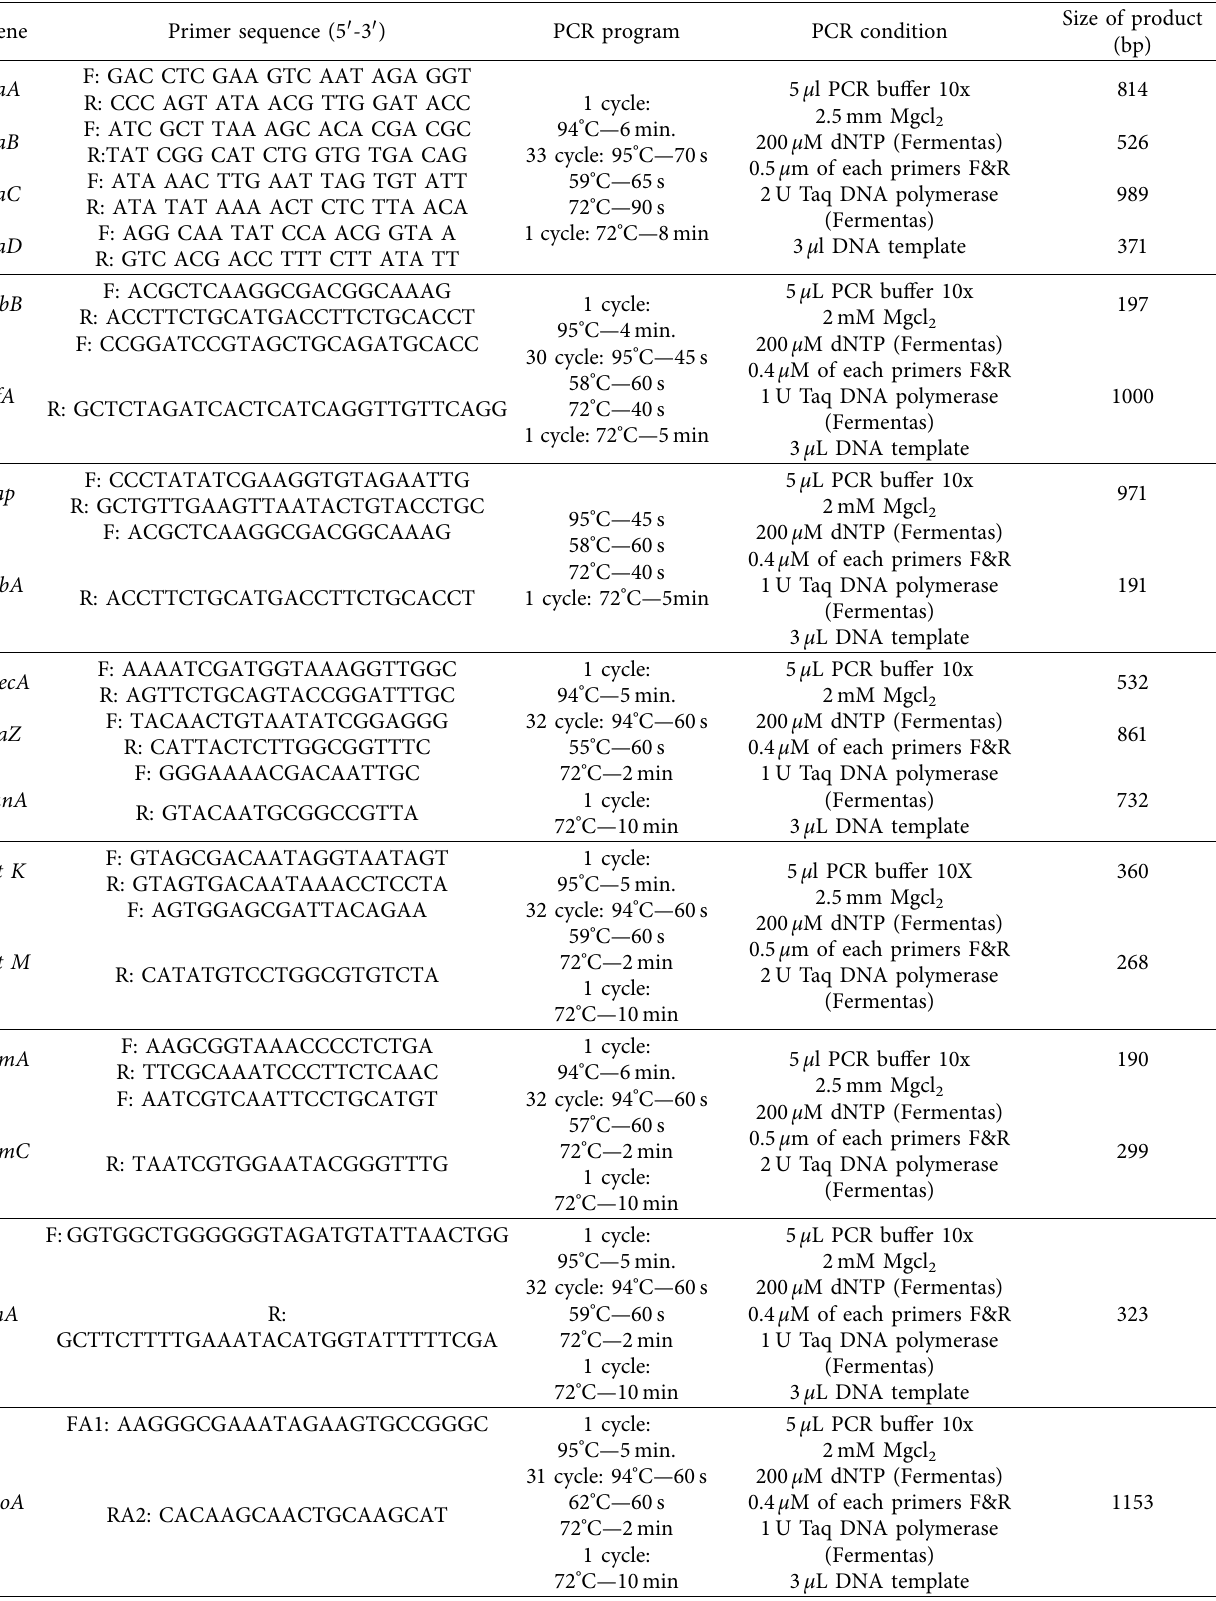
Table 1: Oligonucleotide primers and PCR applications used to amplification of the biofilms genes encoding in S. aureus strains isolated from row cow